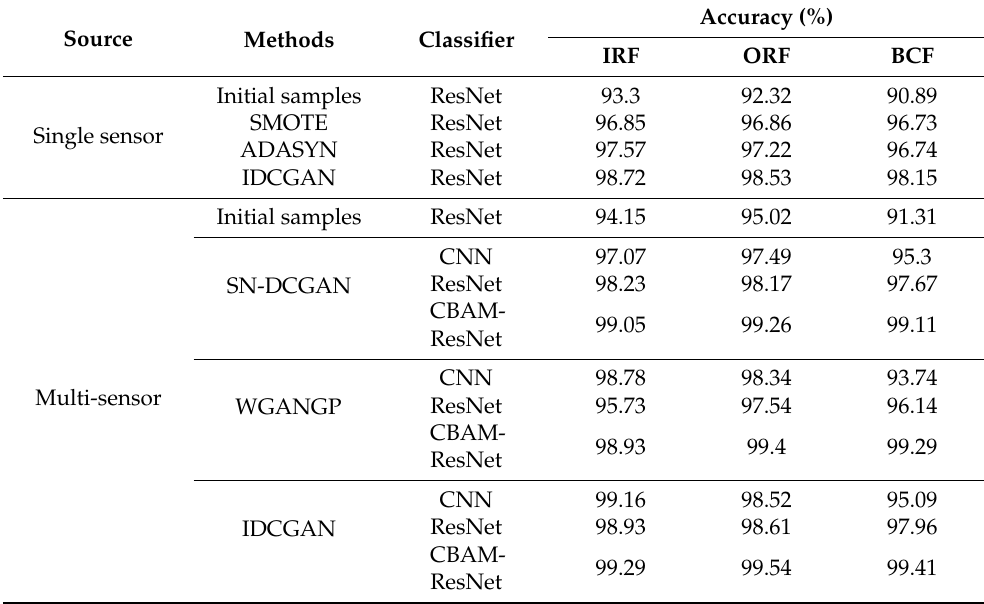
Table 3. Diagnosis results of different minority faults with imbalance ratio of 0.2.